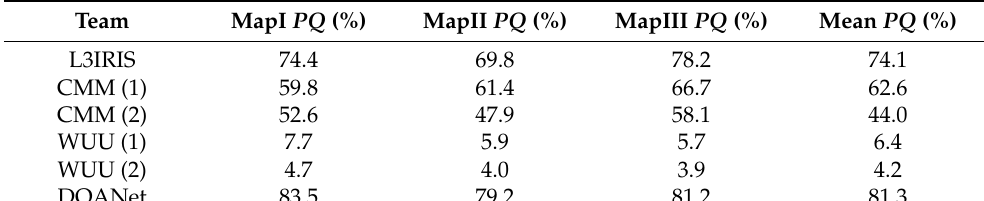
Table 1. Comparison of the evaluation results.